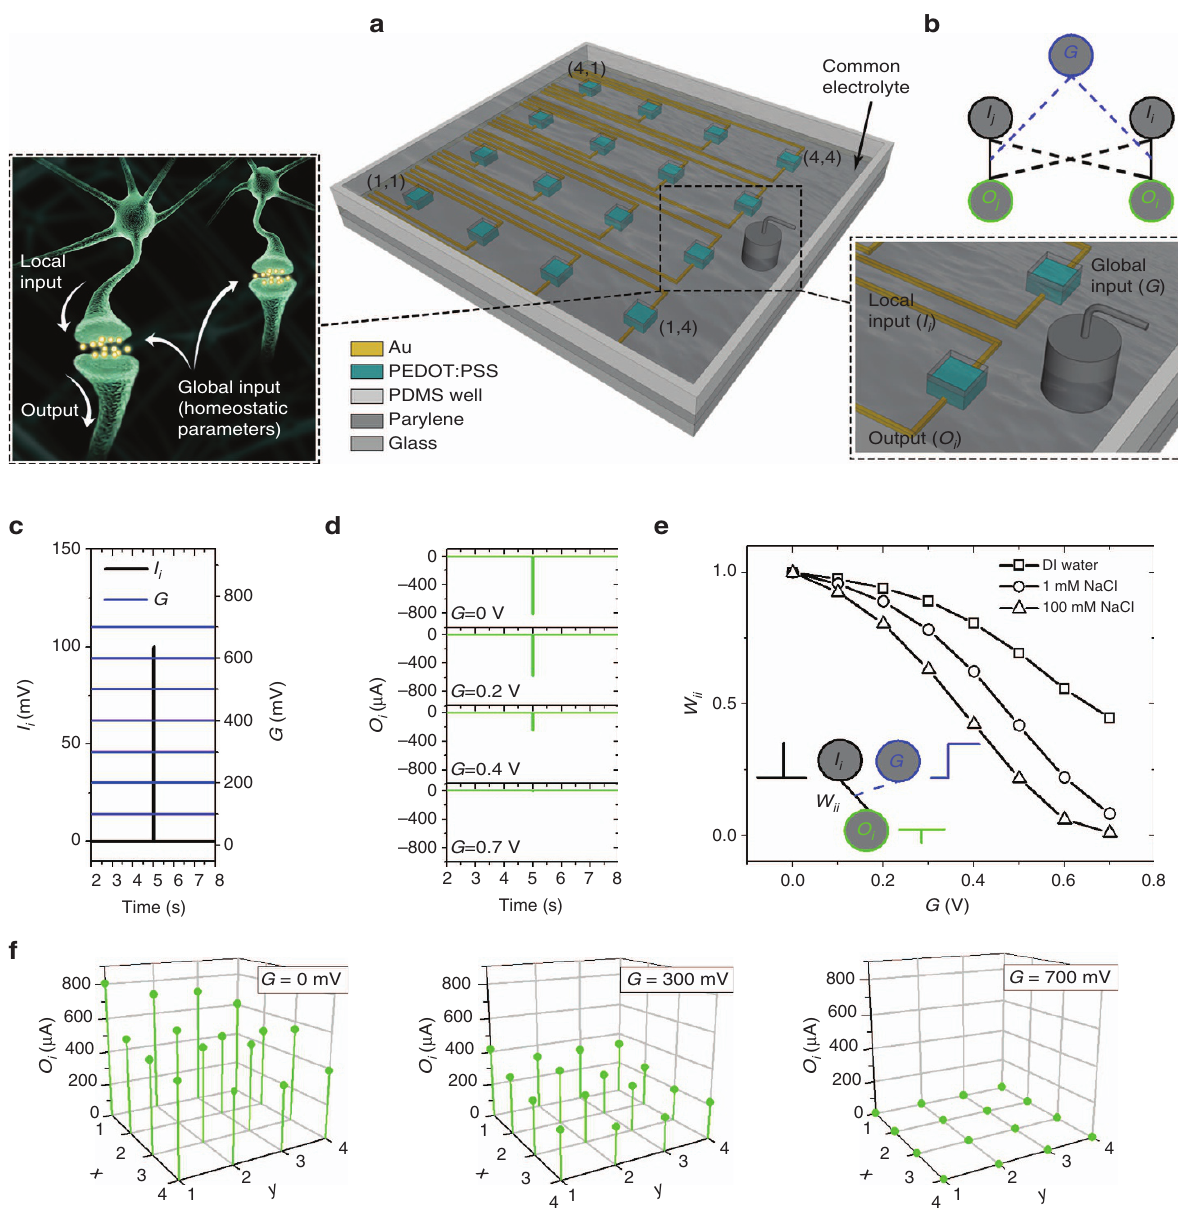
Figure 1 | Configuration of the array and principle of global input. ( a ) Schematic of the configuration of the array of PEDOT:PSS devices. Each device consists of a PEDOT:PSS channel connected with two Au wires, the local input I i and the output O i . The PEDOT:PSS channels are in contact with a common electrolyte in which a Ag/AgCl electrode serves as the global input G . The analogy of the device grid and a system of neurons that are immersed in a common electrolyte is also shown. In neural environment global (homeostatic) parameters regulate the overall function of the brain. ( b ) Representation of the physical (straight line) and soft connections (dash line) that are established in an array of two devices that are immersed in a common electrolyte. ( c ) Combinations of local and global inputs ( I i : pulse of amplitude of 100mV and width of 50ms, G : DC voltage 0–700mV), and ( d ) resulting outputs. ( e ) Connection weight w ii as a function of the global gate voltage G for different electrolyte concentrations (DI water—100mM NaCl). Inset shows that weight w ii quantifies the physical connectivity between input I i and output O i , and that it is modulated by the global input. ( f ) Spatial maps showing the variation of outputs O i , when voltages pulses (amplitude of 100mV, width of 50ms) were used at each local input I i , and various DC values (0, 300 and 700mV) were used as a global input. The Ag/AgCl electrode was located as shown in ( b ). The maps show that global input forces a global restriction on every